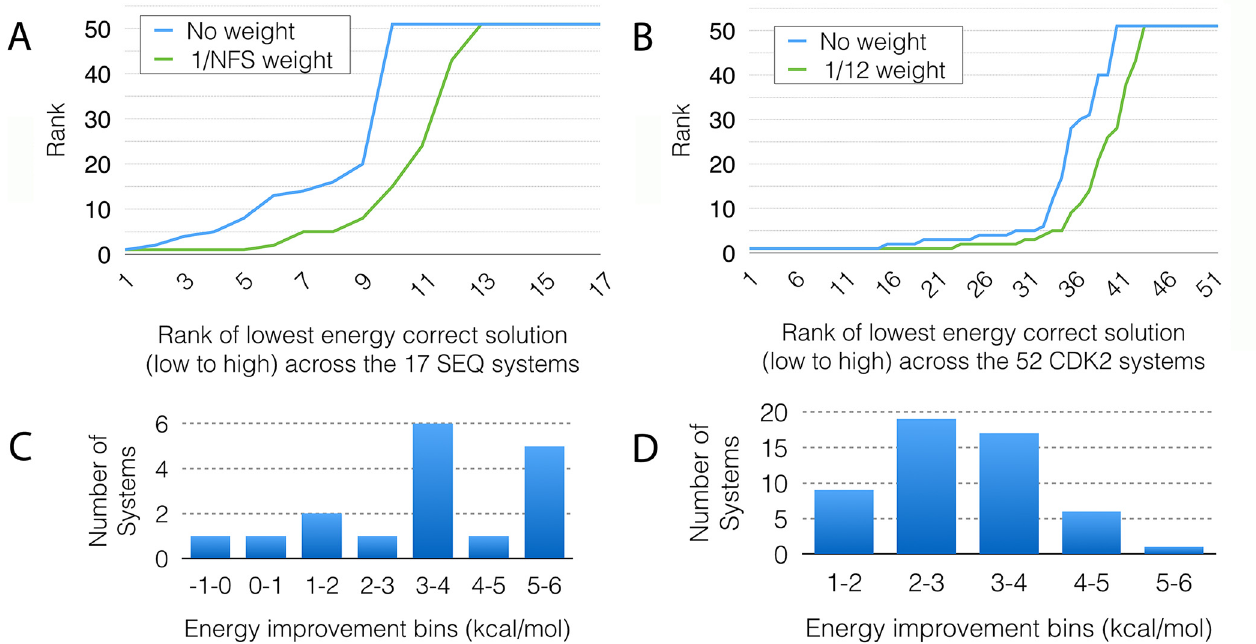
Fig 10. Impact of down-weighting the receptor internal energy. A) and B) Sorted ranks of the correct docked solutions without scaling the receptor energy (blue) and with a scaling factor of 1/ NFS (green) where NFS is the number of flexible receptor side-chains, for the SEQ17 and CDK2 FS12 cross- docking calculations respectively. Overall down-weighting the receptor energy improves the rank of the lowest-energy correct solution. The top horizontal line (Rank 51) in the plots represents data points that did not find the solution in the 50 docking runs. C) and D) Distributions of improvements in receptor-ligand interaction energies ( E R-L ) in kcal/mol, when the internal energy of the receptor is down-weighted in the scoring functions for SEQ17 and the CDK2 FS12 calculation respectively.